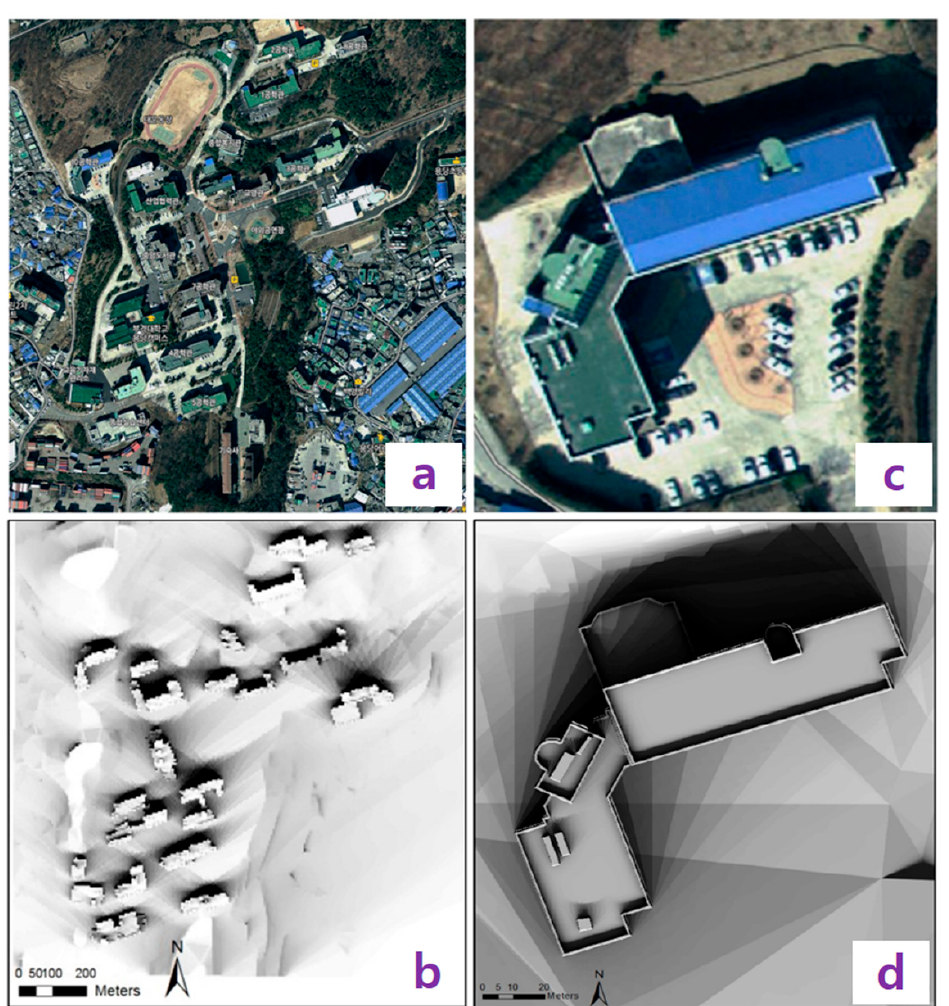
Figure 8. Shadow analysis. ( a ) Satellite image of the study area; ( b ) Shadow analysis of the overall study area; ( c ) Satellite image of a building; ( d ) Shadow analysis of the rooftop area of a building (modified from Song and Choi [78]).